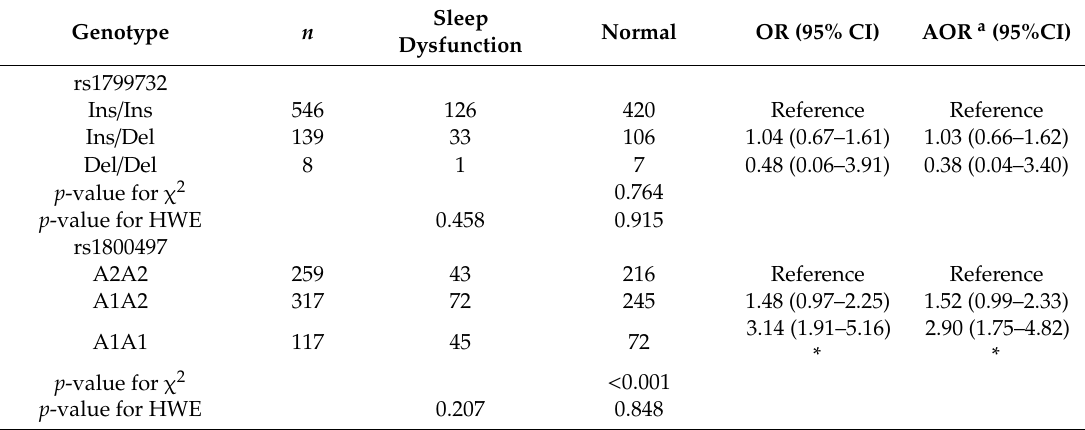
Table 5. Association between DRD2 polymorphism and sleep